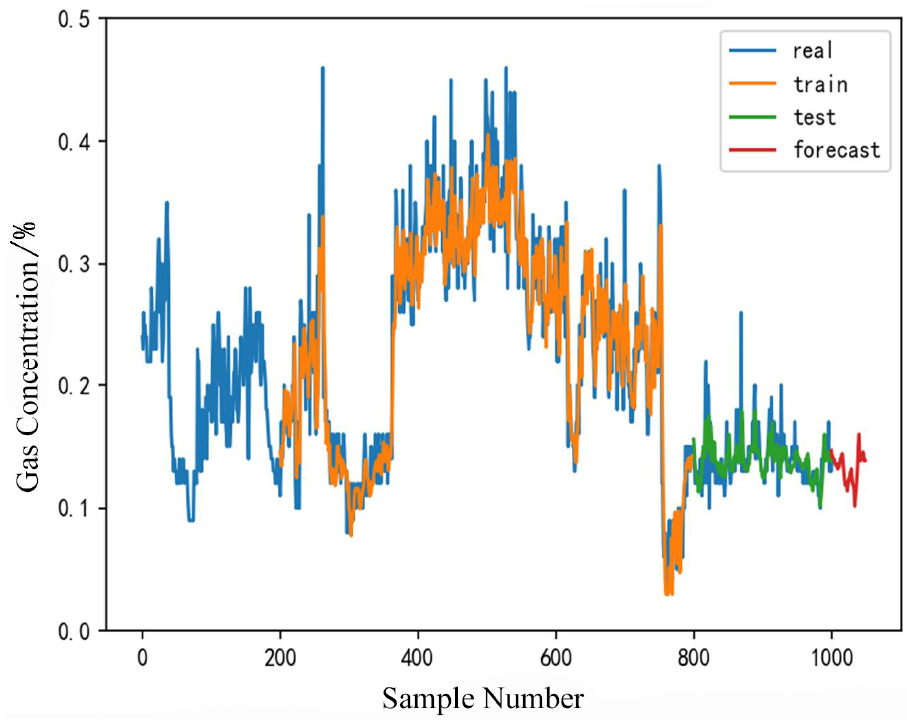
Figure 10. Pearson-LSTM prediction model fitting effect